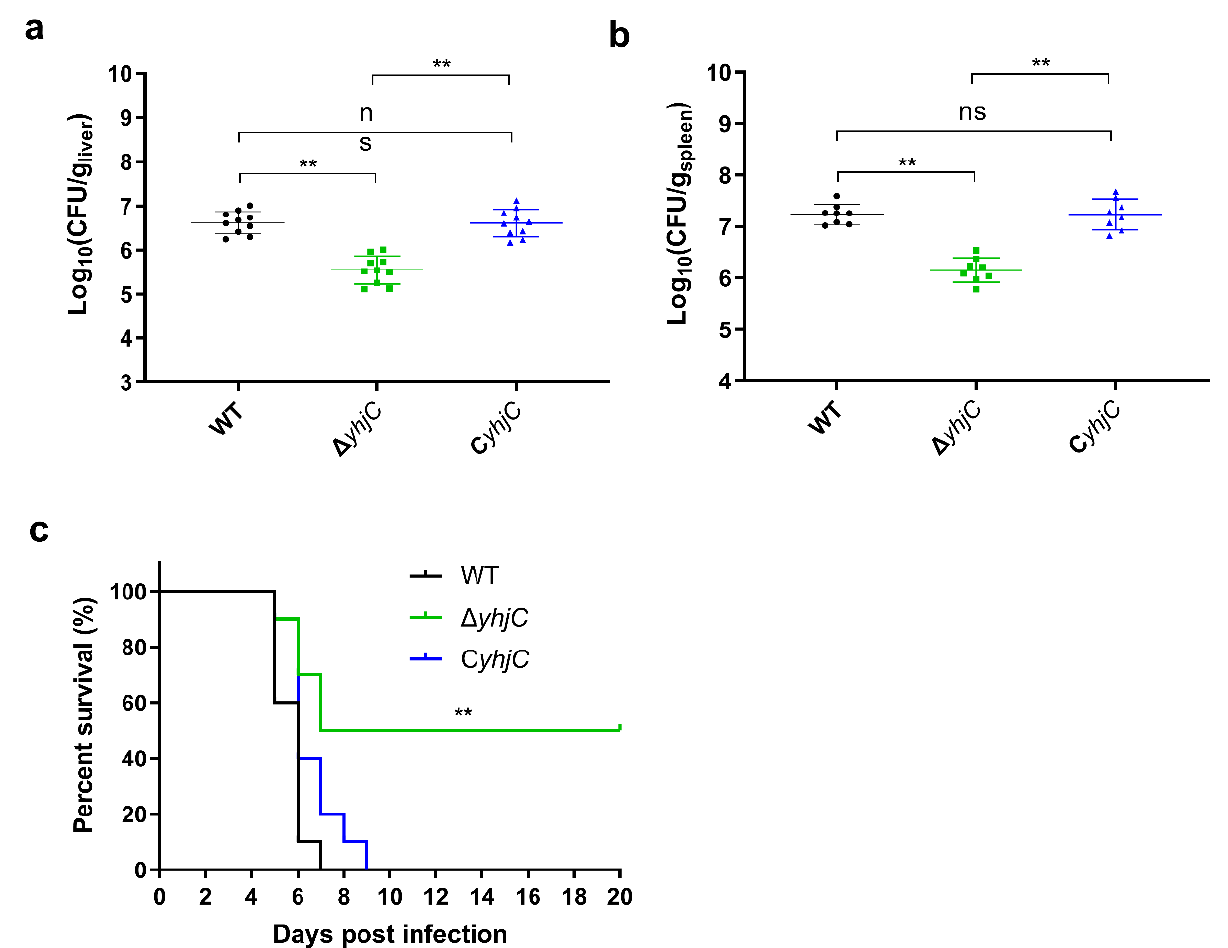
Figure 4. Deletion of yhjC reduced the virulence of S. Typhimurium to mice. ( a , b ) CFU numbers of WT, ∆ yhjC and CyhjC in mouse liver ( a ) and spleen ( b ) at 3 days after intraperitoneal injection of S. Typhimurium. n = 10 mice/group. ( c ) The survival curves for mice infected with WT, ∆ yhjC and CyhjC. n = 10 mice/group. ( a , b ) Data were obtained from three independent experiments and are presented as mean ± standard deviation. The Mann–Whitney U test ( a , b ) or log-rank (Mantel–Cox) test ( c ) was used for the calculation of p values, (** p < 0.01). The transcriptional regulation function of YhjC in S. Typhimurim was further investi- gated by comparing the transcriptomes of WT and ∆ yhjC. WT and ∆ yhjC RNA, used for RNA sequencing, were isolated from bacteria grown in N-minimal medium—the conditions that modulate the environment of macrophages. A total of 16,383,357 and 17,816,971 reads were obtained through RNA sequencing of the WT and ∆ yhjC, respectively, with 99.34% and 99.43% of the reads mapping to the reference genome. A total of 39 genes were dif- ferentially expressed between the ∆ yhjC and the WT strain, including 24 down-regulated genes and 15 up-regulated genes (Table